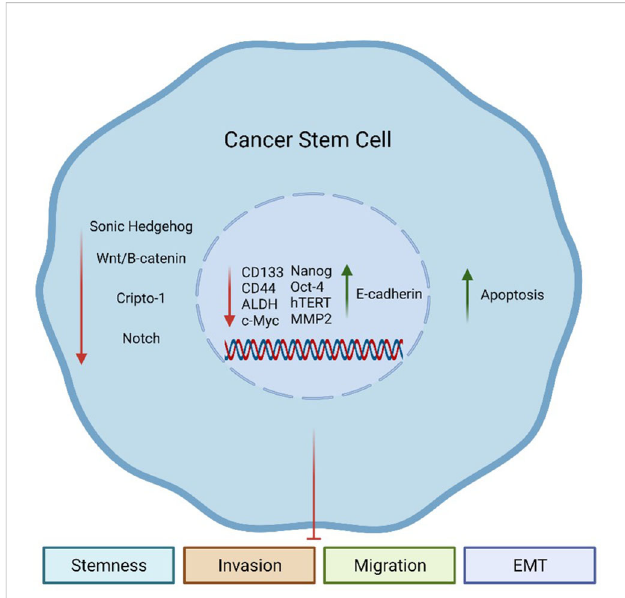
FIGURE 2 Sulforaphane (SFN) effects on Cancer Stem Cells (CSCs). SFN can inhibit aberrantly activated embryonic pathways in CSCs, including Sonic Hedgehog (SHH), Wnt/ b -catenin, Cripto-1 (CR-1), and Notch. Additionally, SFN can decrease the expression of CSC-related genes such as CD133 , CD44 , ALDH , c-Myc , Nanog , Oct-4 , hTERT , and MMP2 . These genes are involved in the maintenance of the CSC population. On the other hand, SFN can increase the expression of E- cadherin, an epithelial marker. All these events together culminate in an increase of apoptosis, while reducing the stemness phenotype of CSCs and their capacity to invade, migrate, and undergo the epithelial-to-mesenchymal (EMT)